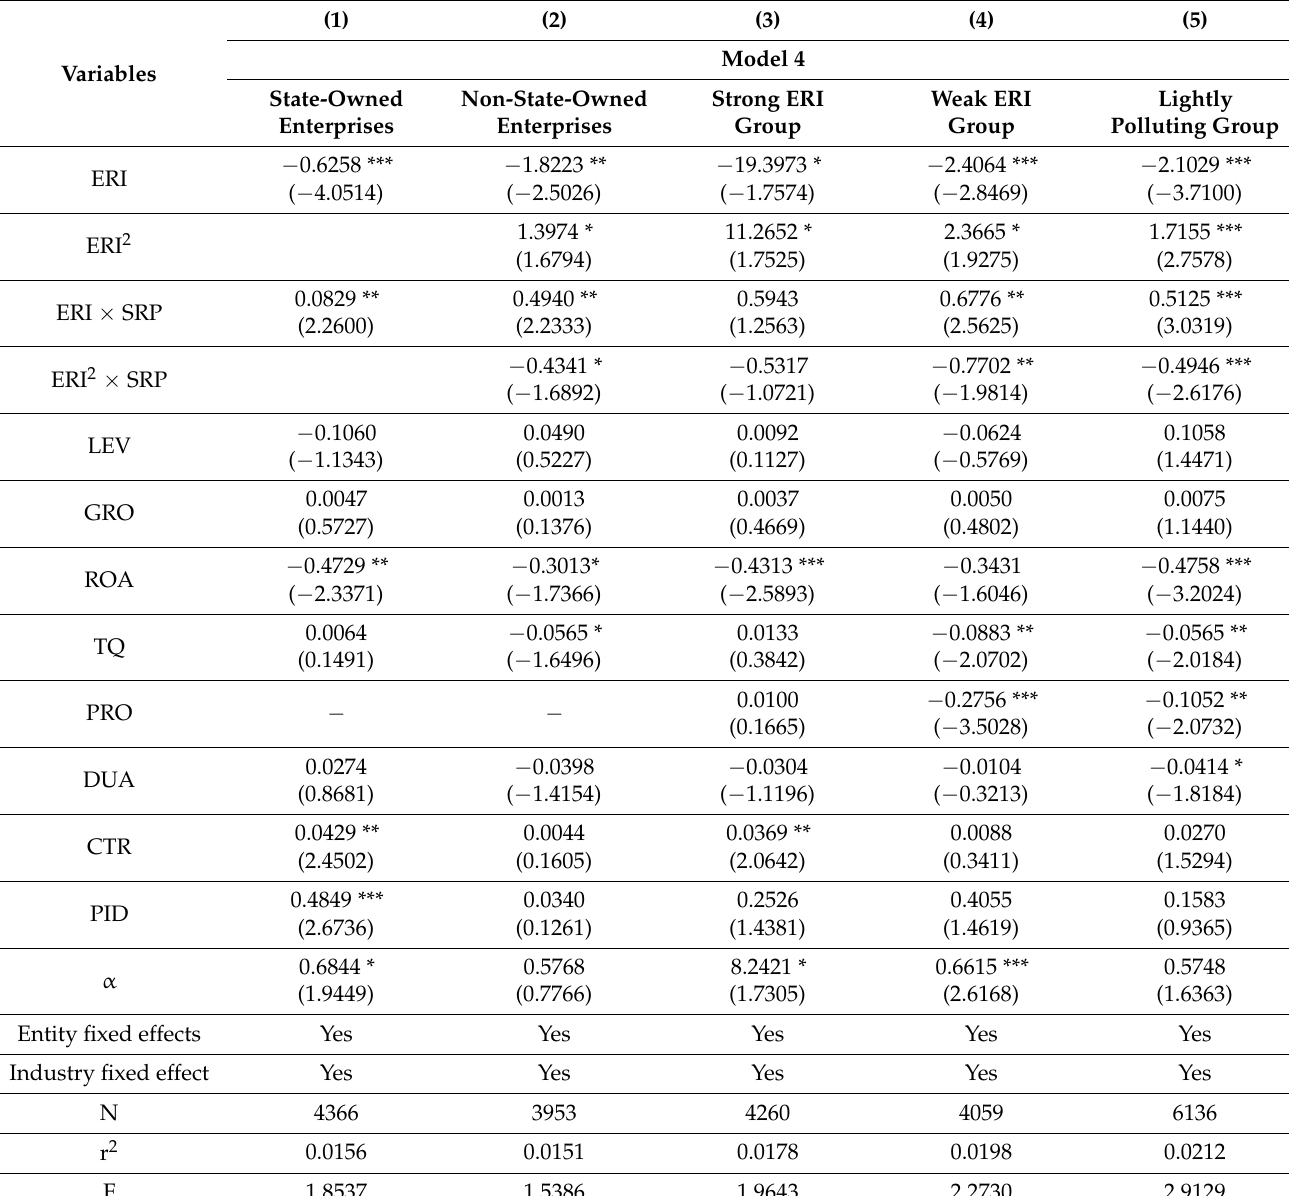
Table 7. Heterogeneity test of the moderating effect of